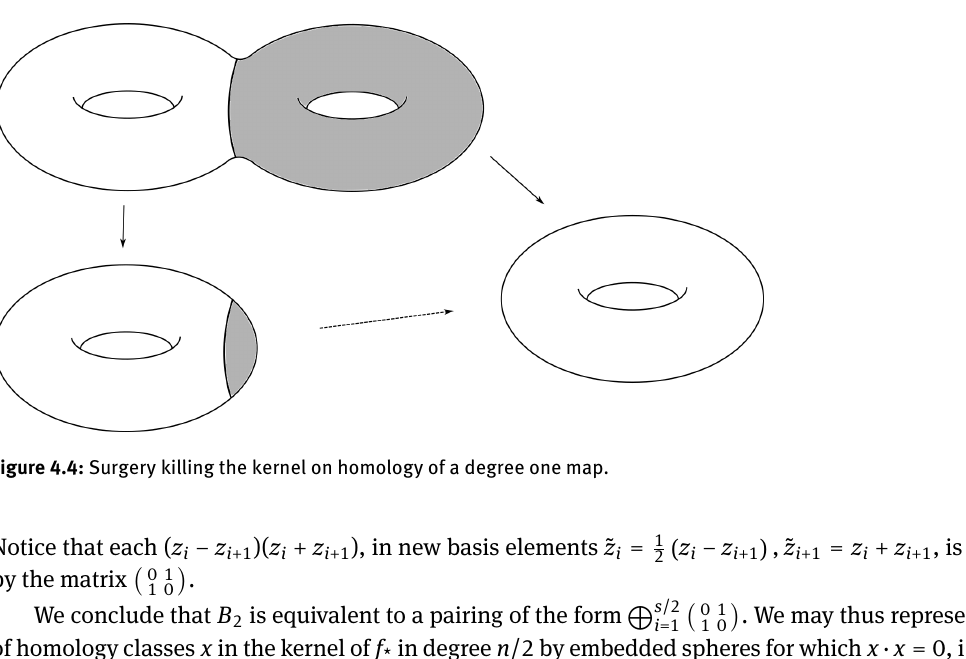
Figure 4.3: Surgery in degree (cid:4) n 2 (cid:5) on a non-zero element in rational homology kills the homology class and its dual under the homology pairing.